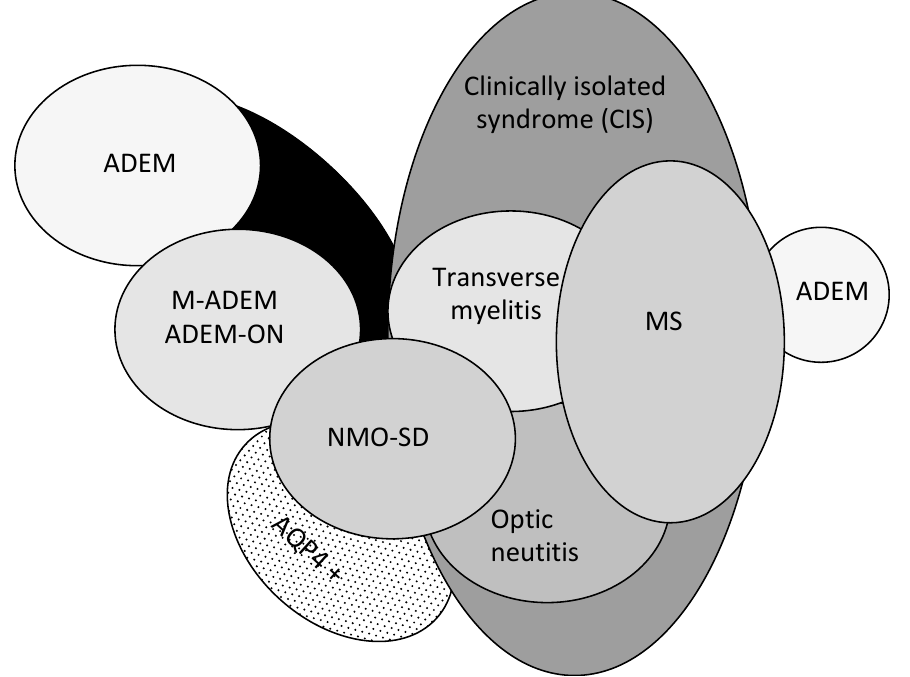
Figure 1. Spectrum of acquired demyelinating syndromes. ADEM, acute disseminated encephalomyelitis; MOG, myelin oligodendrocyte glycoprotein; AQP4 +, aquaporin-4; M-ADEM, multiphasic-ADEM; ADEM-ON, ADEM followed by at least one optic neuritis; NMOSD, neuromyelitis optica spectrum disorder; MS, multiple sclerosis (adapted from Neuteboom et al. [16].).